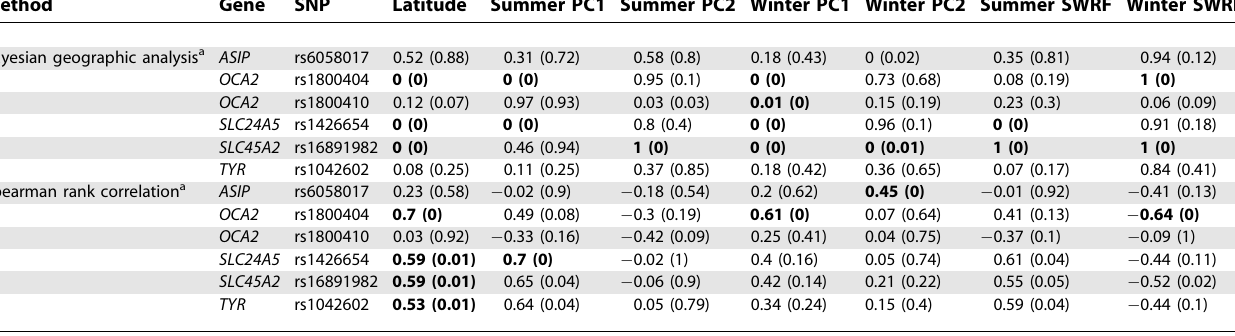
Table 3. Coefficients and p -Values (in Parentheses) for Pigmentation Candidate SNPs. Method Gene Bayesian geographic analysis a